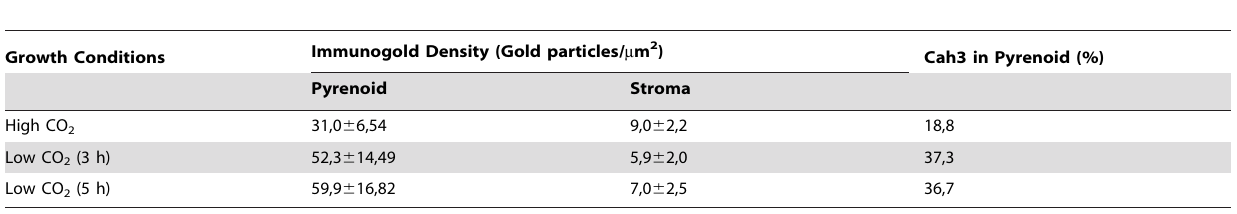
Table 1. Calculation of Cah3 fraction in both the pyrenoid and the stroma of the chloroplast of both high-CO 2 cells and cells acclimating to low CO 2 conditions for 3 and 5 h.